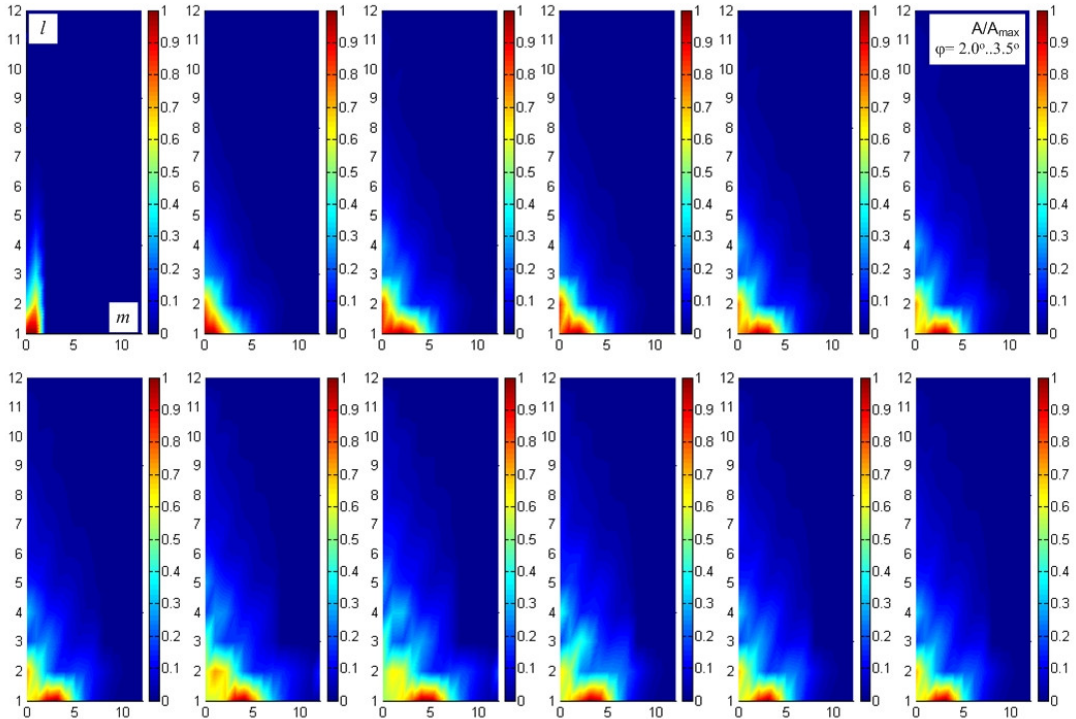
Figure 4. Normalized amplitude distribution dynamics over the guided mode staff of the reference MMF under a centralized mode LP 01 and LP 11 launching, and following mode mixing and power redistribution due to the fiber bends being represented as a connection of regular spans with weak angular misalignment, which is empirically defined as a range of φ = 2.0 ◦ . . . 3.5 ◦ .